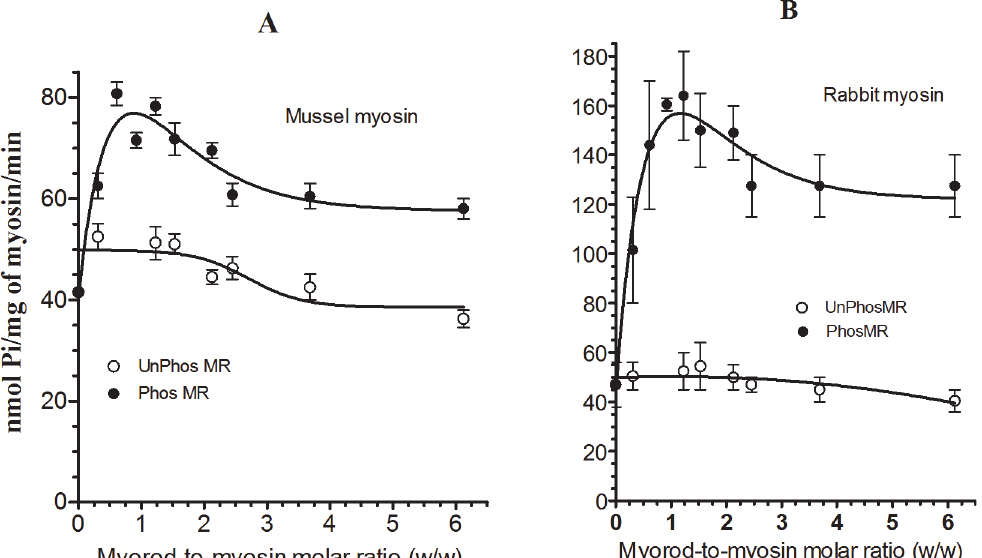
Fig 5. Actin-activated Mg 2+ -ATPase activity of molluscan (A) and rabbit (B) myosin co-assembled in the presence of UnPhosMR or PhosMR at different molar ratios. The ATPase activity was measured in 100 mM KCl, 0.5 mM MgCl 2 , 0.5 mM DTT, 0.1 mM Ca 2+ , 10 mM imidazole, pH 7.2. Concentration used: mussel and rabbit myosins, 0.1 mg/ml; rabbit F-actin, 0.2 mg/ml; UnPhosMR and PhosMR, (0.025 – 0.5 mg/ml). Curves of five experiments are shown.